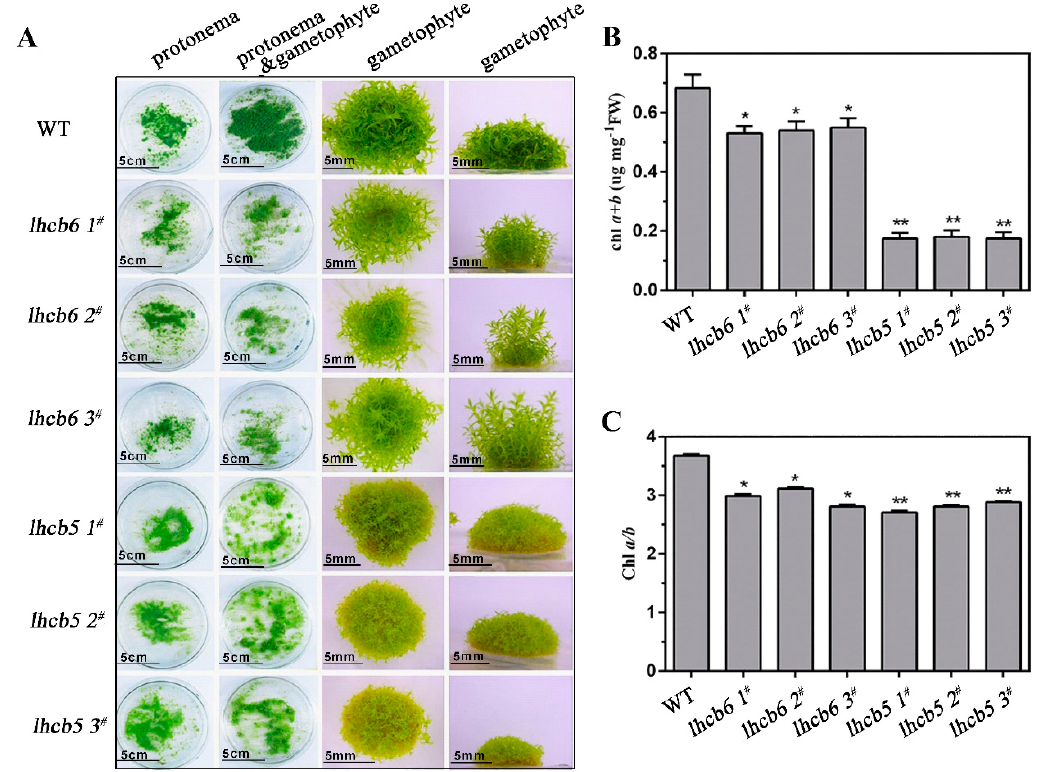
Figure 6. The phenotype and chlorophyll content of wild-type and mutant plants. ( A ) The protonema and gametophyte phenotypes of wild-type and mutants. The protonema tissues of wild-type and mutants were grown for one week on ammonium tartrate-free BCD medium. The protonema and gametophyte tissues were grown in this medium for four weeks. The gametophyte tissues were grown in the same medium for six-weeks. The chlorophyll a + b content ( B ) and chlorophyll a / b ratio ( C ) of leafy gametophyte tissues. FW, Fresh weight. The data represent the means ± SD of three biological replicates. Statistical significance compared with the wild-type is indicated by asterisks (** p ≤ 0.01, * p ≤ 0.05, Student’s t -test).